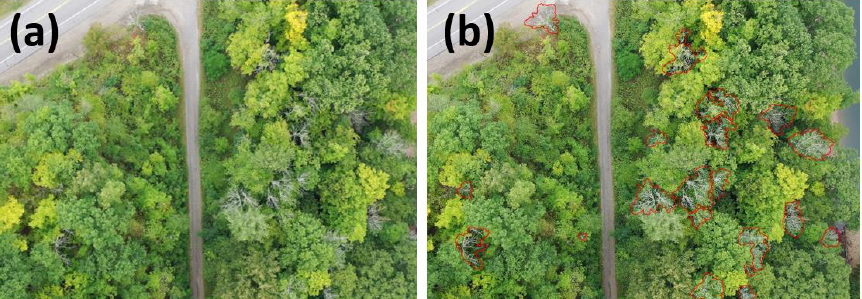
Figure 7. An example of the original RGB image ( a ) and its manual annotations ( b ) of declining and dead ash trees, which are outlined in red.